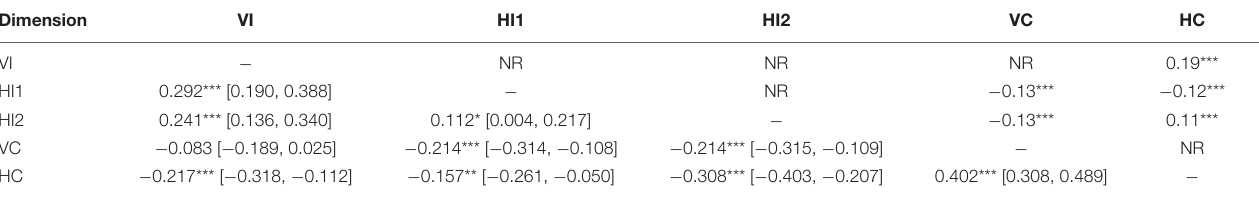
TABLE 8 | Comparison of the estimated correlations in the current (below diagonal) and original study (above diagonal) of the Czech version of INDCOL by Bartoš (2010). Dimension VI